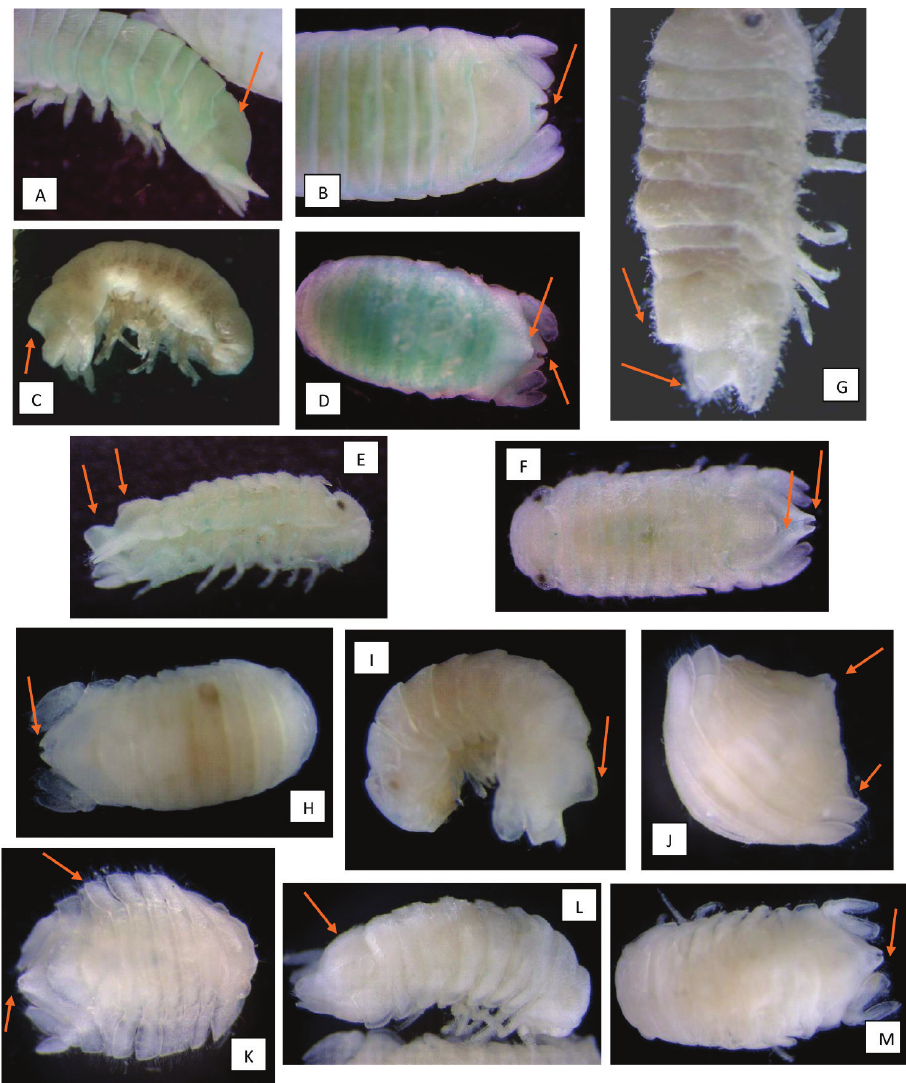
Figure 3. Main features of females and juveniles of the NE Atlantic-Black Sea axis Dynamene spp. A, B Dynamene bidentata (S. Wales). Arrows indicate smooth outline of pleotelsonic dome ( A ) and non- tubular pleotelsonic foramen ( B ) C, D Dynamene magnitorata (Roscoff, France). Arrows indicate angular outline of pleotelsonic dome ( C ), posterior extension of pleotelsonic keel and non-tubular pleotelsonic foramen ( D ) E, F, G Dynamene edwardsi (Italy). Arrows indicate angular outline of pleotelsonic dome ( E ) with central bulge ( E, F, G ) and tubular pleotelsonic foramen. ( E and F from Naples, Italy G hirsute female from the Venice Lagoon, Italy) H, I Dynamene bicolor (Naples, Italy). Arrows indicate angular out- line of pleotelsonic dome ( I ) and non-tubular pleotelsonic foramen ( H ) J , K Dynamene tubicauda (Ischia, Italy). Arrows indicate flattened epimera surrounding body that give this species a unique body shape ( J, K ) and the tubular pleotelsonic foramen ( J, K ) L, M . Dynamene bifida (Ischia, Italy). Arrows indicate smooth outline to pleotelsonic dome ( L ) and pleotelsonic foramen at end of short tube ( M